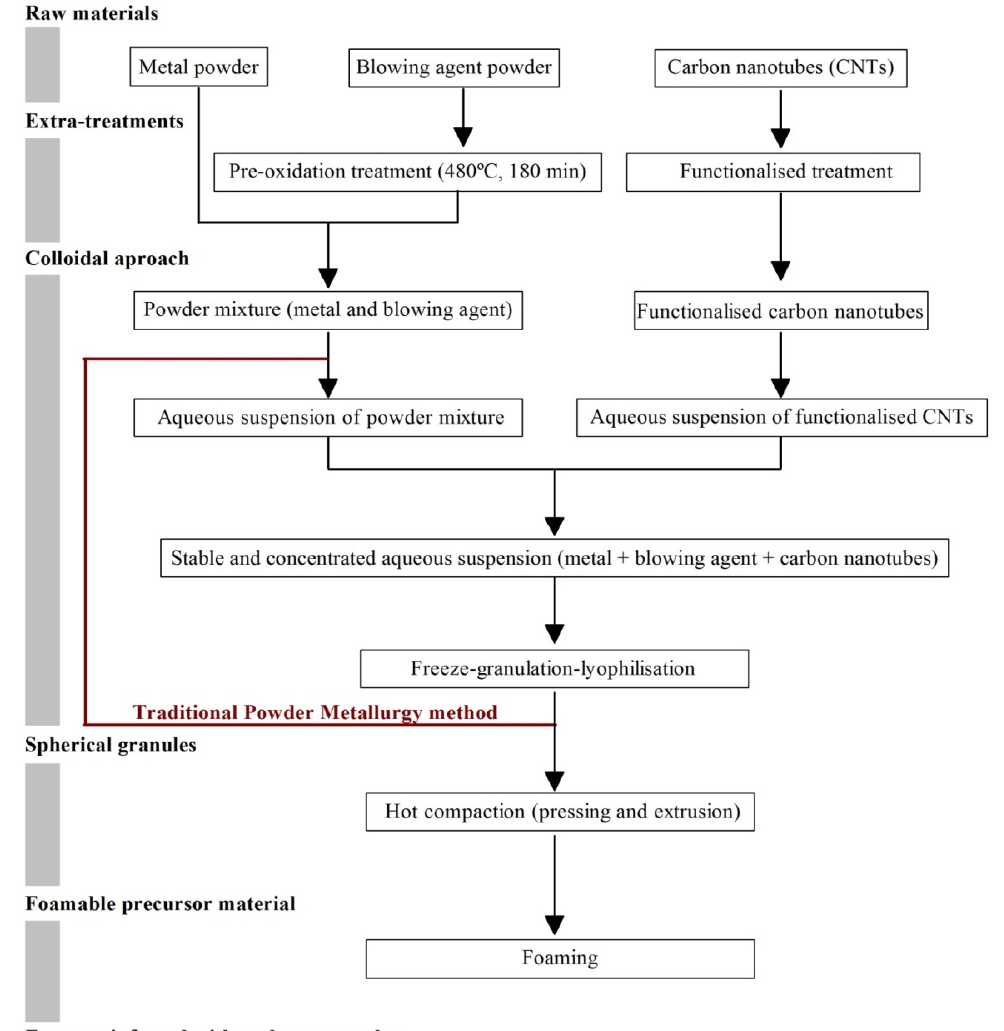
Figure 7. Schematics of the novel approach for preparing metal ‐ foams reinforced with carbon